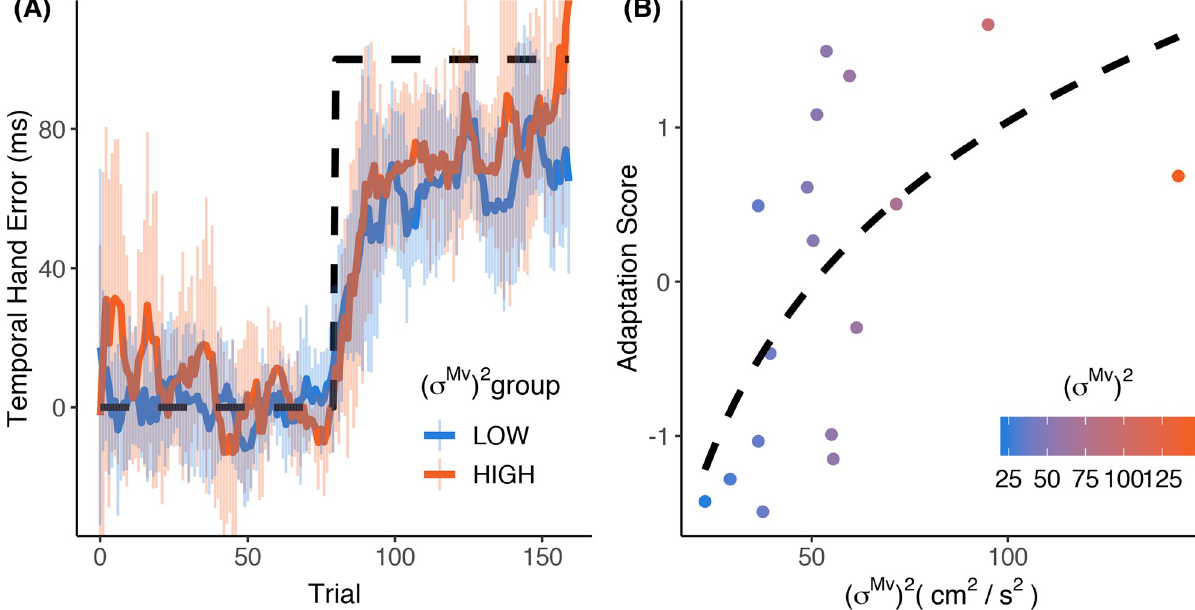
Fig 3. The relationship between ( σ Mv ) 2 and adaptation score. (A) The moving average data (+- SD) of the LOW (blue) and HIGH (orange) variability group. (B) The relationship between ( σ Mv ) 2 and the Adaptation Score.